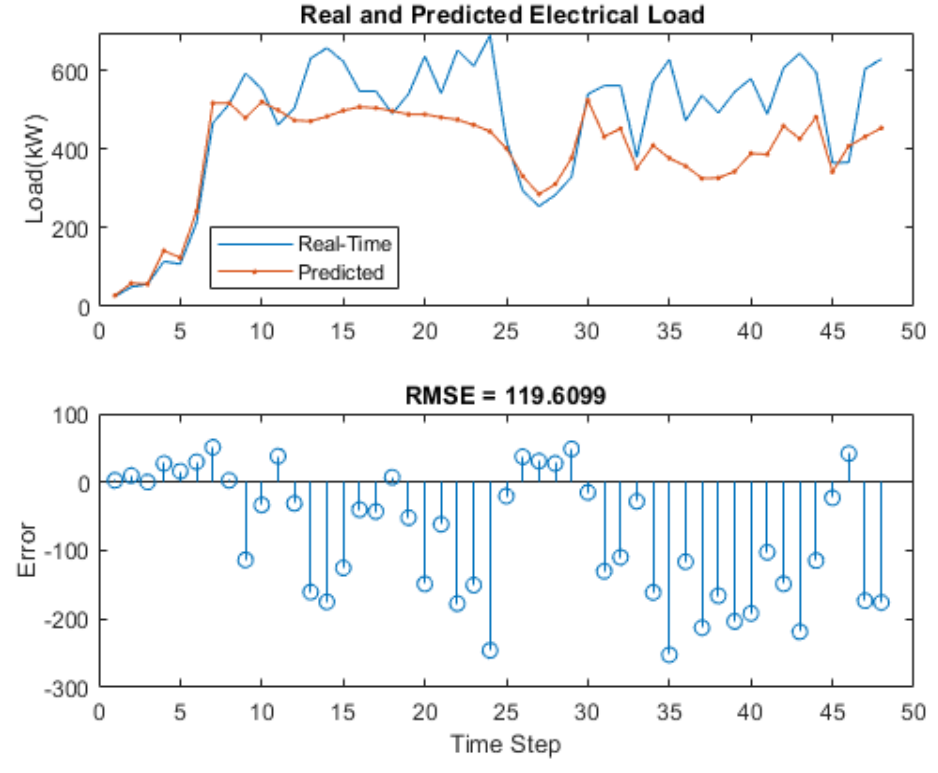
Figure 6. Real and predicted electrical load with RMSE.